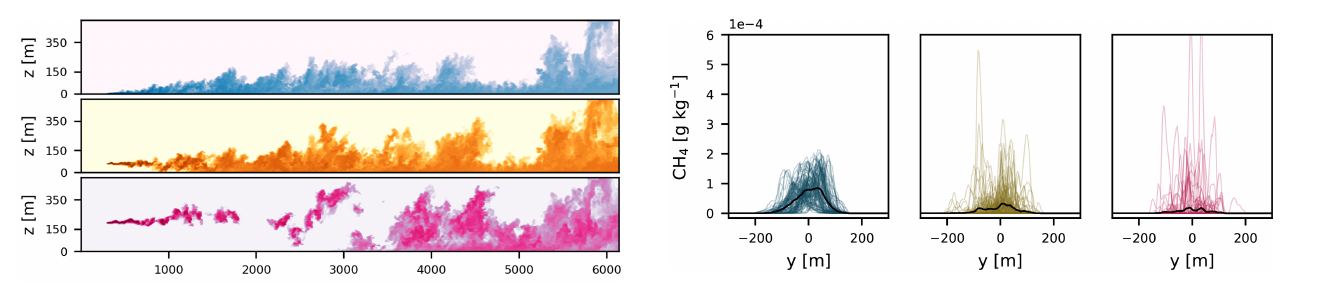
Figure 5. Example of 100 instantaneous transects from three plumes, taken at the emission height of the respective plumes, at a distance of 1248m from the source. The mean of the 100 plumes is shown in black. Blue, brown, and pink correspond to emission heights of 0, 60, and 190m,